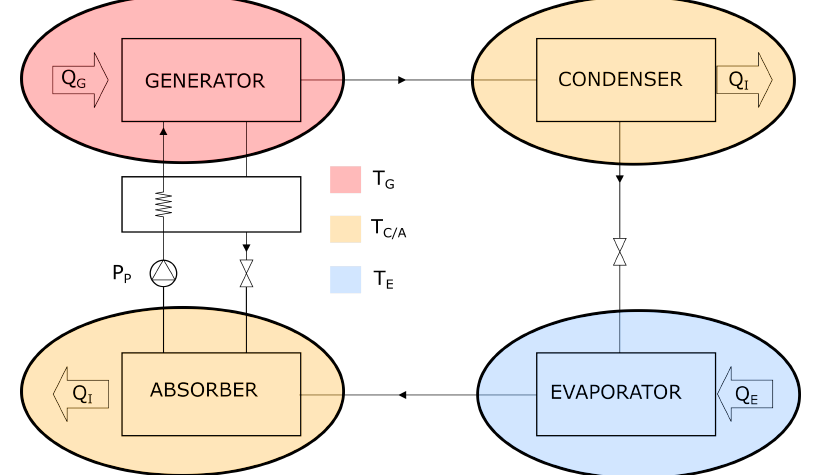
Figure 2. Schematic representation of an absorption